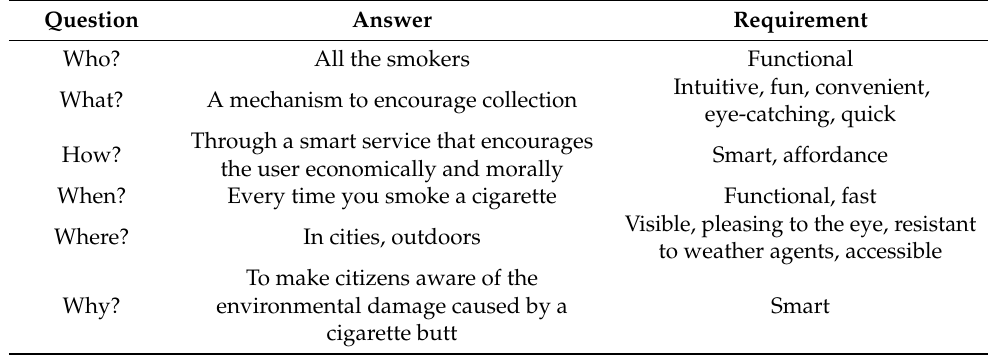
Table 1. Six Questions.